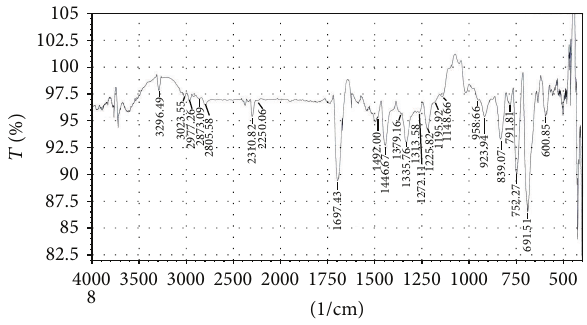
Figure 13: FTIR spectrum of t (3)-methyl- r (2), c (6)-diphenylpipe- ridin-4-one (02).